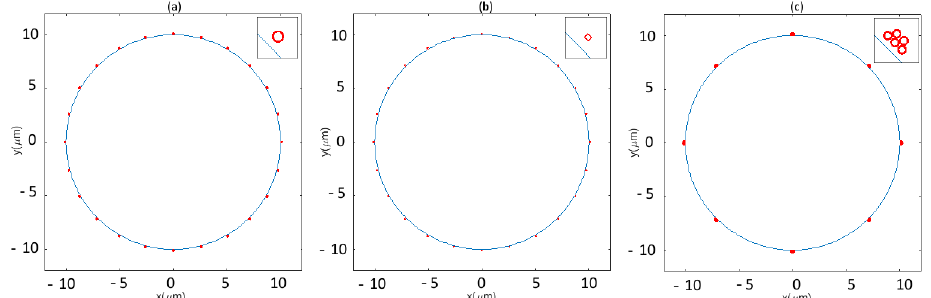
Figure 2. Schematic view of the three Au NP configurations around the cell: for each condition, the enlarged view of the NPs geometry is plotted in the upper right corner of the panel; ( a ) 24 spherical Au NPs placed at angular distance among them equal to 15°; ( b ) 24 cubic Au NPs placed at angular distance among them equal to 15°; ( c ) 40 spherical Au NPs grouped in 8 clusters, each composed of 5 NPs.